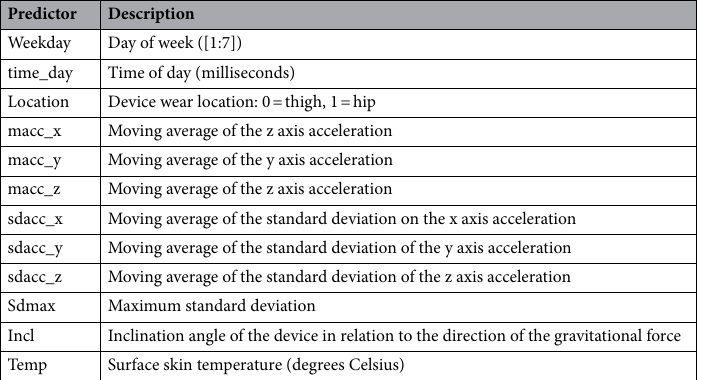
Table 1. Predictors derived from the raw sensor signals.